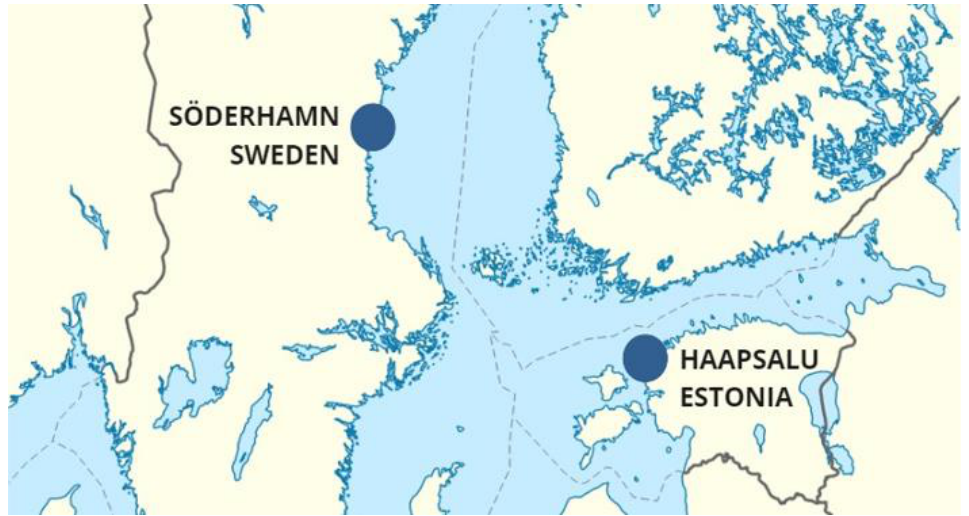
Figure 4. Case study areas are located in the Baltic Sea region. Haapsalu is located on the west coast of Estonia and Söder- hamn on the west coast of Bothnia Bay in Sweden. of Estonia and Söderhamn on the west coast of Bothnia Bay in